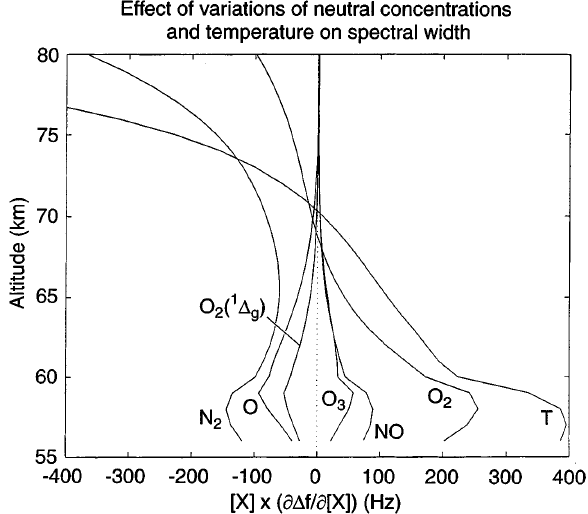
Fig. 8. E(cid:128)ects on the spectral width from changes in the concentra- tion of various neutral constituents, and in the neutral temperature. The plot shows the scaled partial derivatives of spectral width with respect to the concentrations of some relevant constituents, as well as the temperature. Each derivative has been multiplied by the concentration of the corresponding constituent, or by